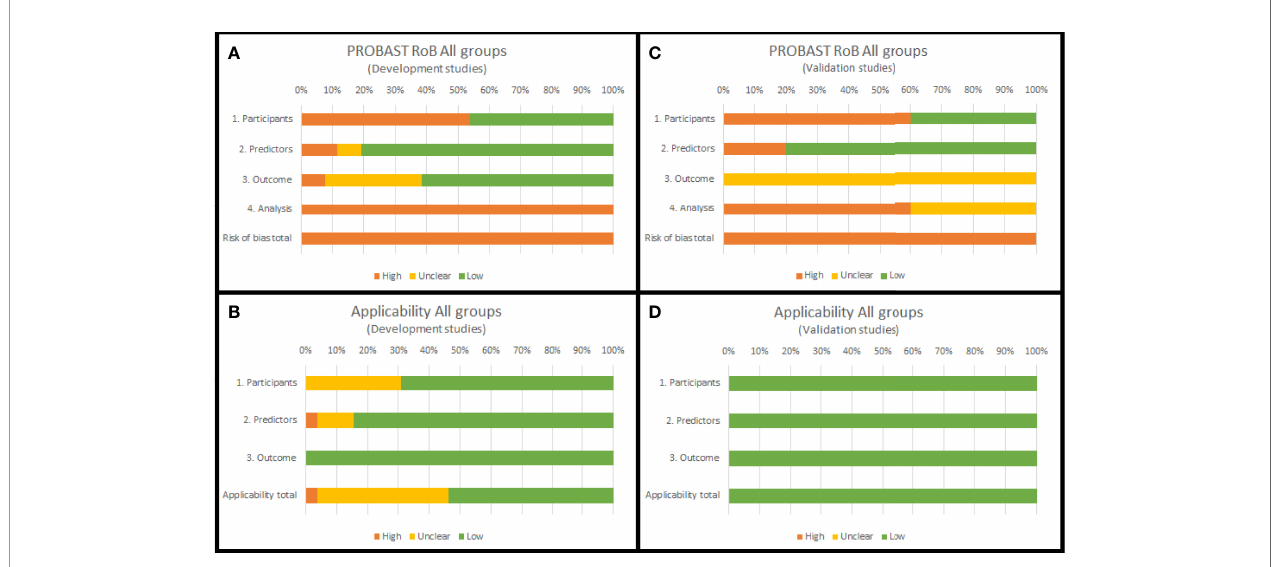
FIGURE 3 | PROBAST summary (RoB domains and applicability domains) for all nomogram development (A, B) and validation studies (C, D) included in this systematic